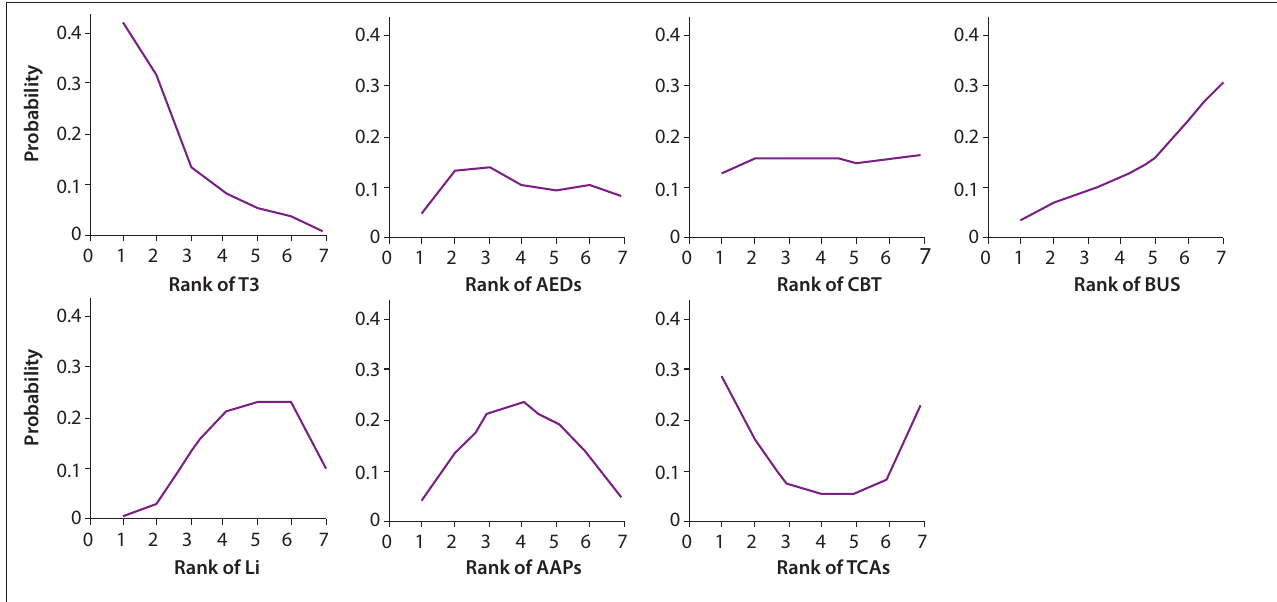
Fig. 3. Ranking for efficacy of seven augmentations. Ranking indicates the probability to be the best treatment, the second best, the third best, and so on. (T3 = tri-iodothyronine; AEDs = antiepileptic drugs; CBT = cognitive behaviour therapy; BUS = buspirone; Li = lithium; AAPs = atypical antipsychotics; TCAs = tricyclic antidepressants.)